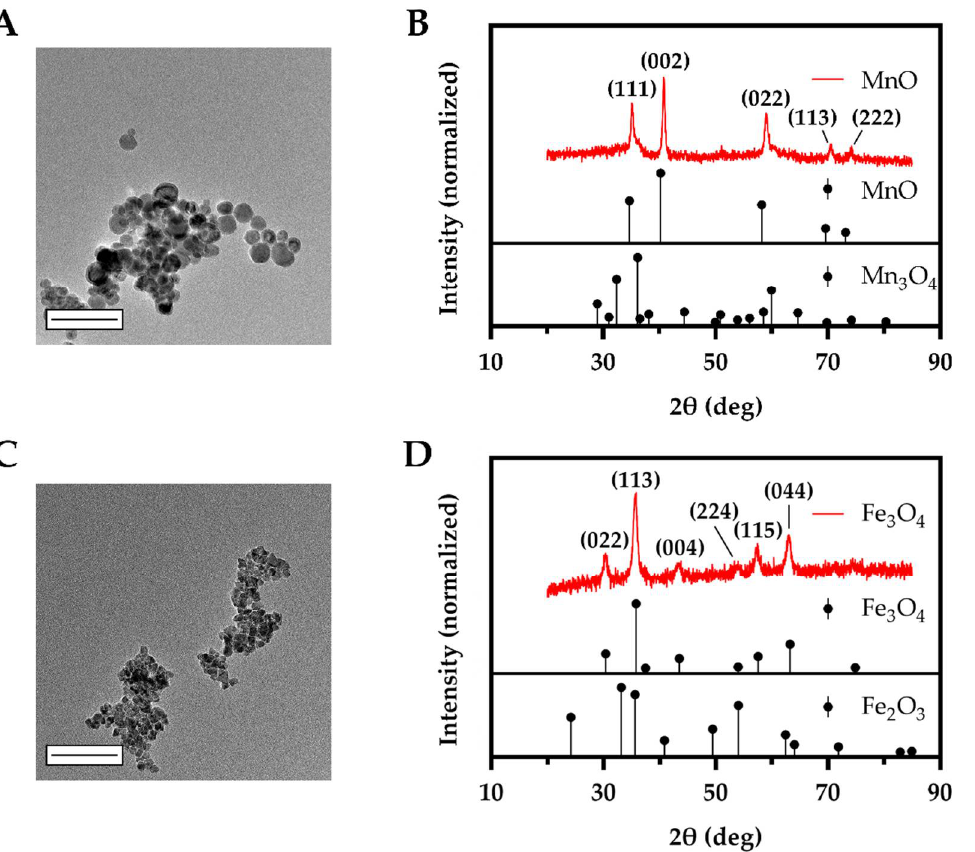
Figure 1. TEM images and XRD spectra of synthesized MnO ( A , B ) and Fe 3 O 4 ( C , D ) bare NPs confirm the size and crystal structure. The measured XRD spectra of ( B ) MnO NPs and ( D ) Fe 3 O 4 NPs for one of two batches synthesized are shown in red with the corresponding Miller indices shown for each peak. Standard diffraction peaks for known MnO, Mn 3 O 4 ( B ) and Fe 3 O 4 , Fe 2 O 3 ( D ) are shown in black using X’Pert HighScore. The measured spectra showed characteristic peaks of MnO and Fe 3 O 4 , respectively. Scale bars are 100 nm.